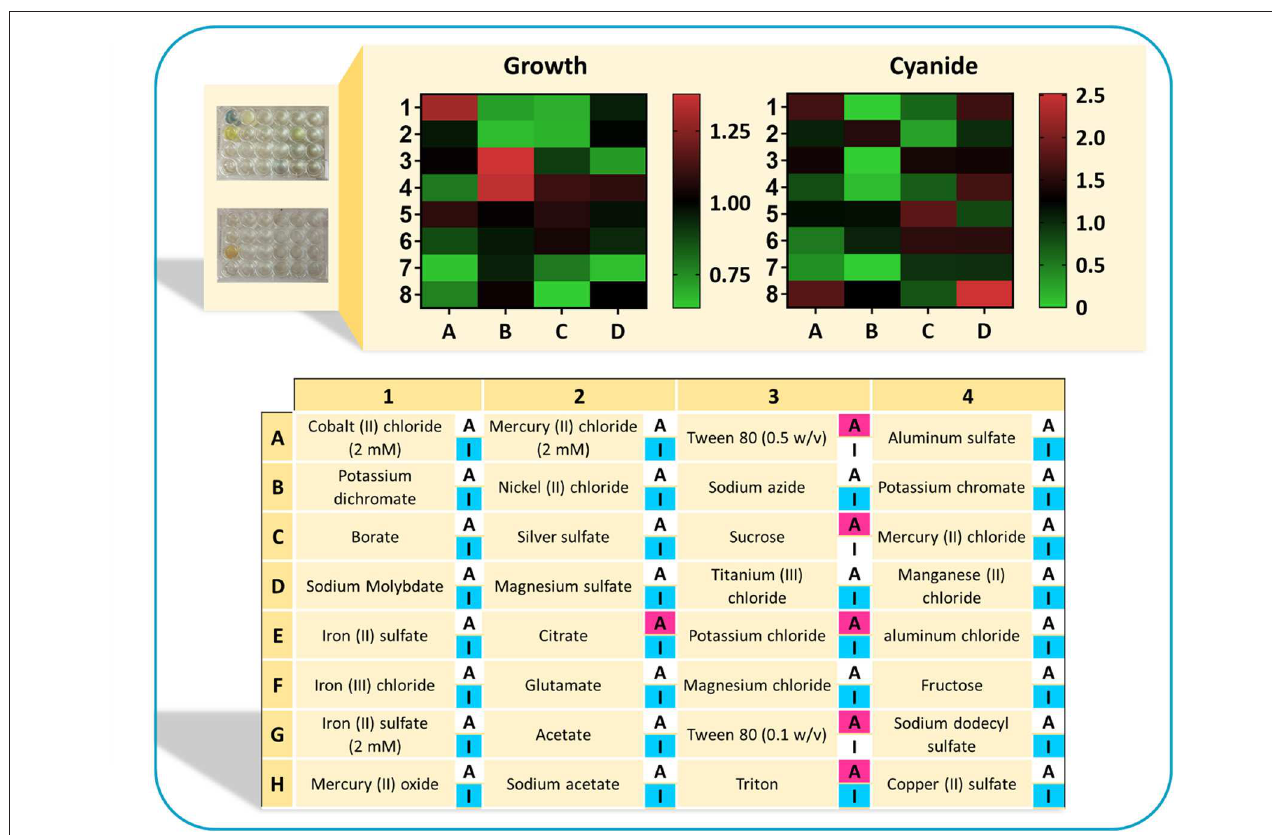
FIGURE 8 | The results of normalized optical density and normalized cyanide concentration in a heat-map view. Each cell represents the measuerments of bacterial growth and cyanide concentration when supplementing the CDM1 medium with a single regulator. Both bacterial growth presented in terms of OD 600 , as well as the cyanide concentrations were normalized with respect to growth and cyanide concentration in the CDM1 medium. Highlighted “A” refers to the potential activators and “I” refers to the potential inhibitors. Some components could have both activatory and inhibitory